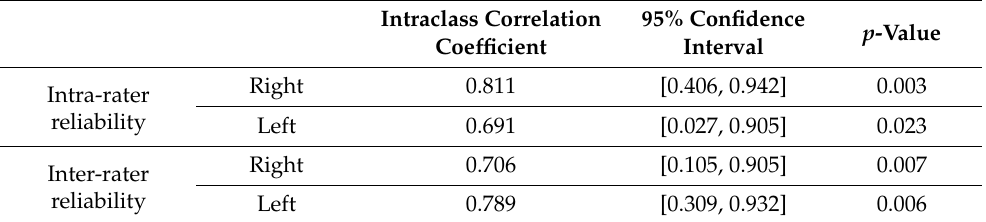
Table 1. Intra- and inter-rater reliability of the force-closure instrument (n = 13).